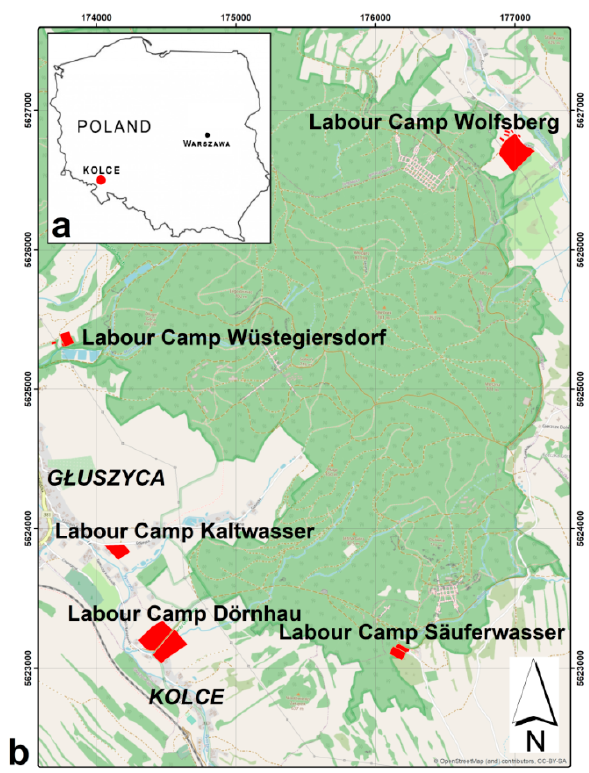
Figure 1. Study Area: ( a ) overview map with the marked location (red point) ( b ) and map with the former camps selected for the study. Coordinate grid: UTM Zone 34 N (EPSG: 32634). © OpenStreetMap.